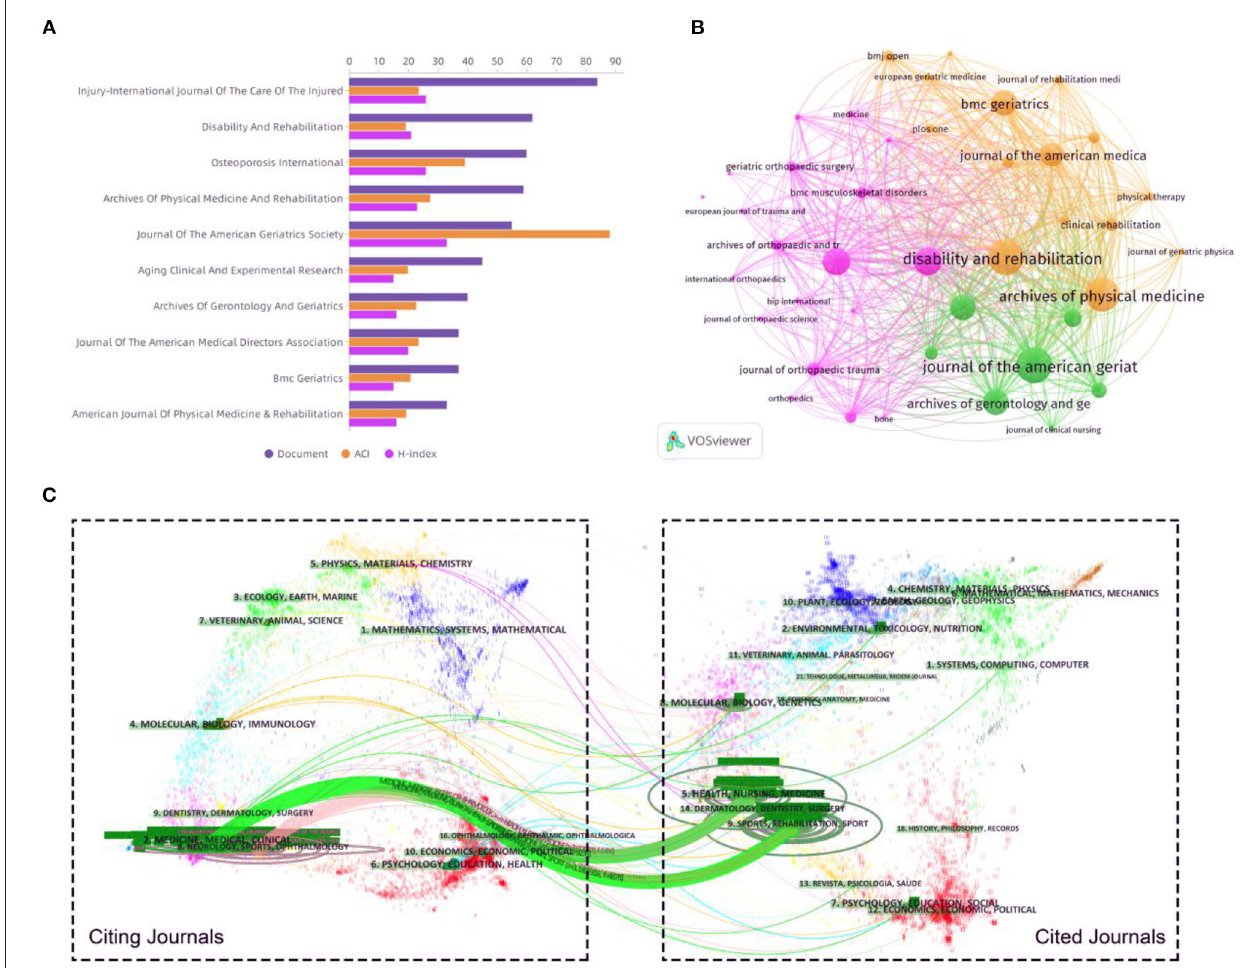
FIGURE 4 | (A) The document counts, H-index, and ACI of the top 10 journals. (B) Network visualization map of journal co-citation analysis based on VOSviewer software. (C) The dual-map overlay of academic journals on rehabilitation of hip fracture in the elderly (generated by CiteSpace